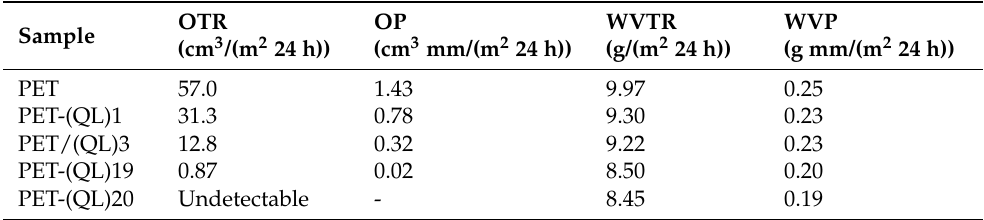
Table 2. Barrier properties of PET and PET–quad-layer systems [100]. OTR: oxygen transmission